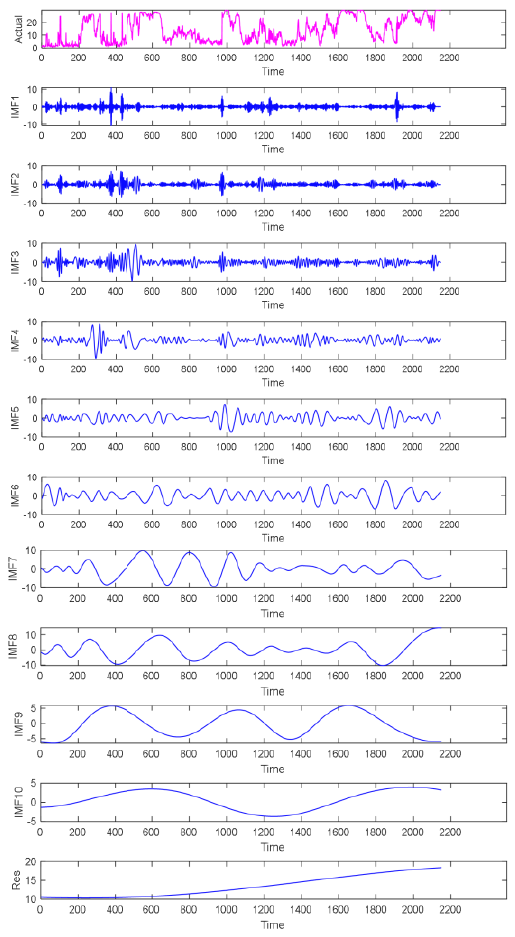
Figure 5. Diagram of original WP data and its EMD decomposition.